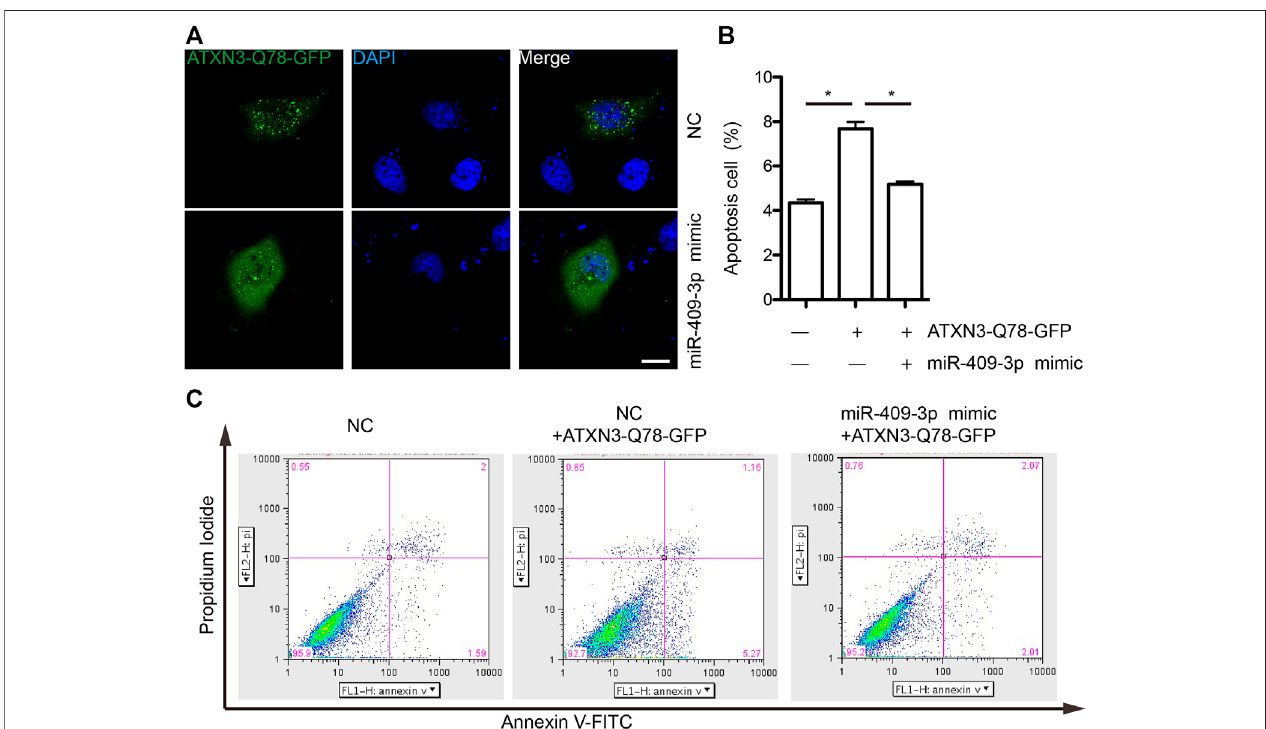
FIGURE7| miR-409-3pdecreasethecelltoxicityofATXN3-Q78-GFP (A) theaggregatesofATXN3-Q78-GFPwereobservedinSH-SY5Ycellswithtransfectionof miR-409-3p mimic or negative control (NC). (B) Statistical results of apoptosis detected by fl ow cytometry in SH-SY5Y cells with transfection of miR-409-3p mimic or negative control (NC). Student t -test, *, p < 0.05. (C) Apoptosis were detected by fl ow cytometry in SH-SY5Y cells with transfection of miR-409-3p mimic or negative control (NC) using annexin-V-FITC and PI